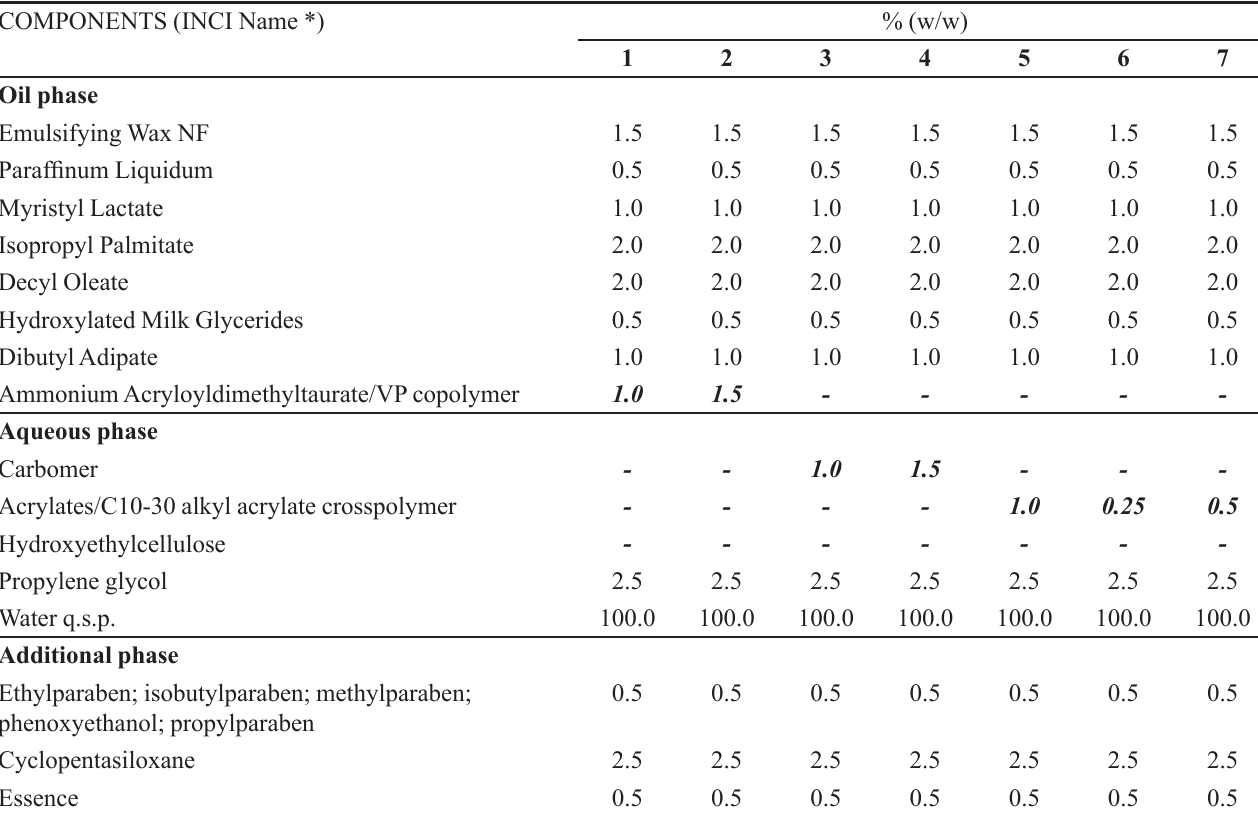
TABLE I – Qualitative and quantitative composition of the formulations containing 0.8% of papain, prepared for macroscopic evaluation and sensorial aspect ( 1 to 7